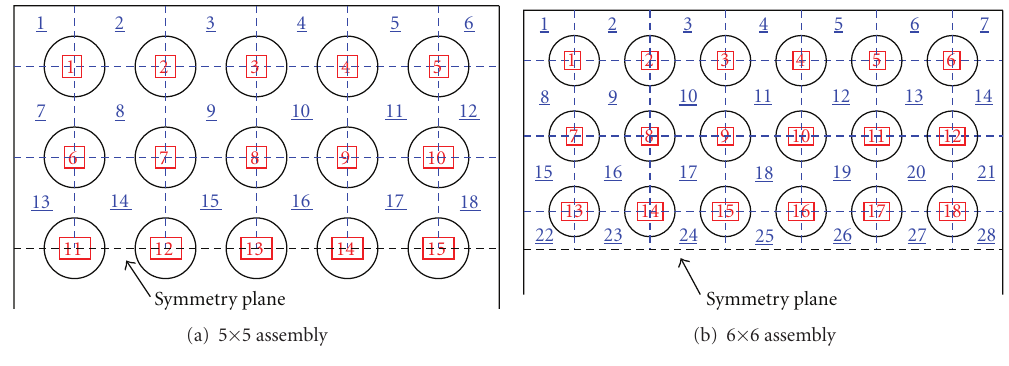
Figure 19: 1/2 symmetry